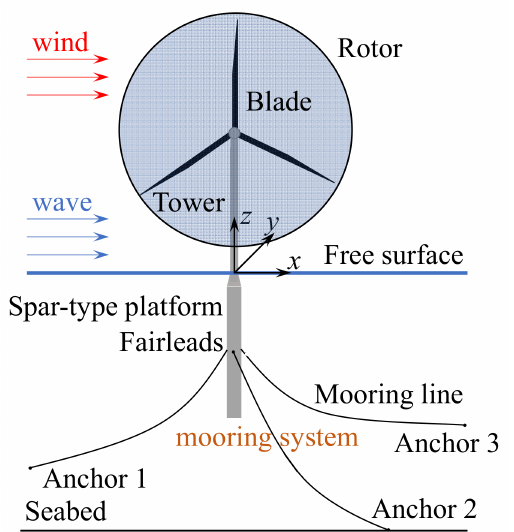
Figure 4. Schematic of OC3-Hywind Spar-type 5 MW offshore floating wind